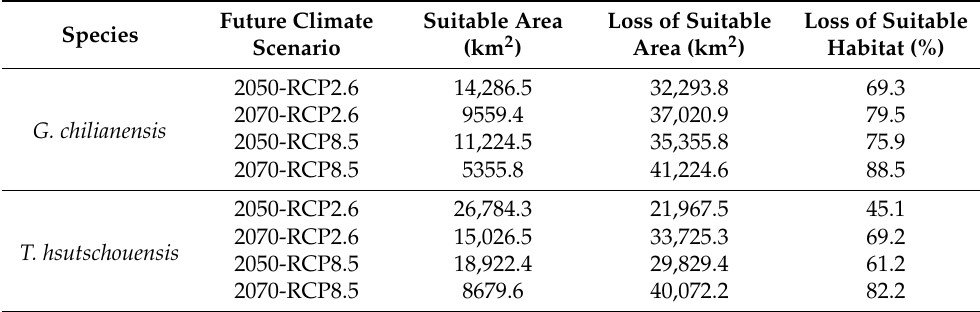
Table 4. Changes in suitable habitat areas of G. chilianensis and T. hsutschouensis under future climate scenarios. Species